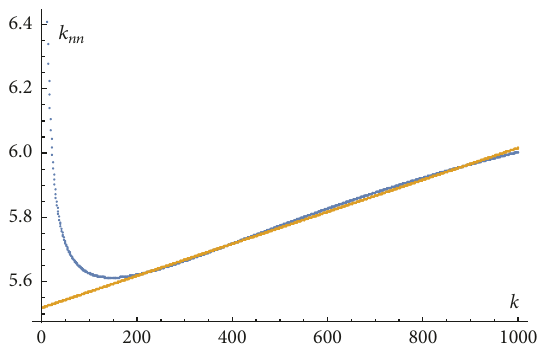
Figure 7: Function 𝑘 𝑛𝑛 for a BA network with 𝛽 = 1 , 𝑛 = 1000 ( 𝑁 ≃ 10 6 ). A linear fit for large 𝑘 is also shown. The slope is approximately equal to 5 ⋅ 10 −4 ; a comparison with Figure 6 shows that the slope decreases with increasing 𝑛 , but is still not